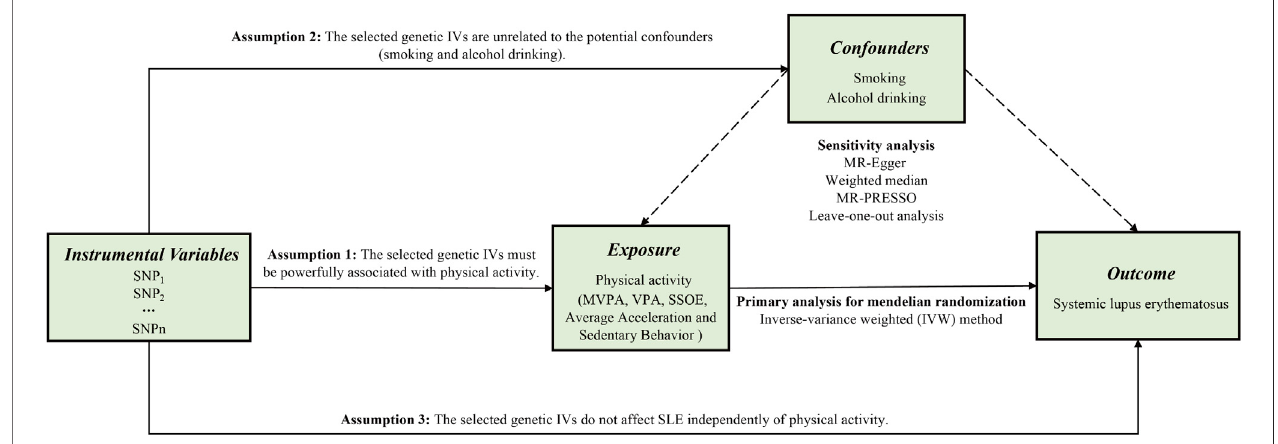
FIGURE 1 | An overview of this Mendelian randomization (MR) study design. Abbreviations: SNP, single nucleotide polymorphism; MVPA, Moderate-to-vigorous physicalactivity;VPA,vigorousphysicalactivity;SSOE,strenuoussportsorotherexercises;IVs,instrumentalvariables;SLE,systemiclupuserythematosus;MR-Egger, Mendelian randomization-Egger; MR-PRESSO, Mendelian randomization pleiotropy residual sum and outlier test.